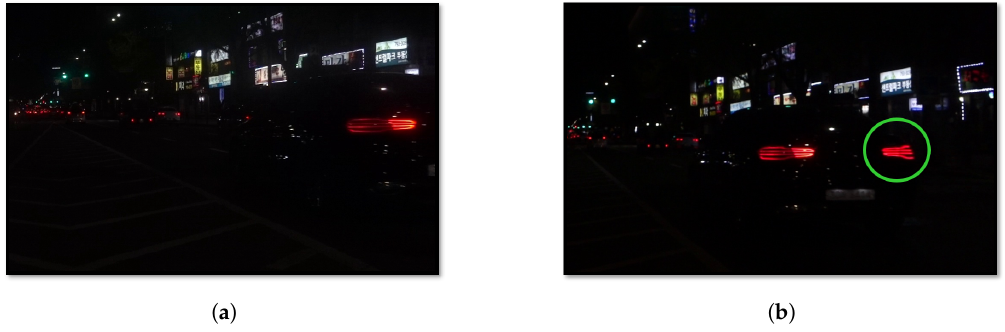
Figure 14. Out-of-view phenomenon: ( a ) left image; ( b ) right